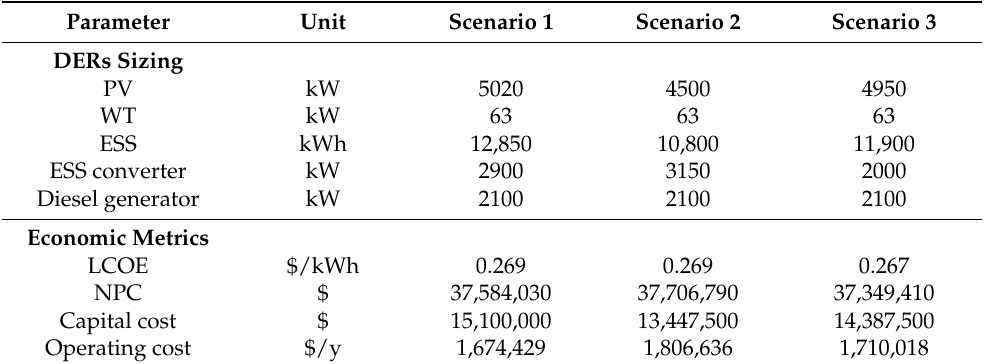
Table 8. Summary of economic metrics of the optimal configurations for three